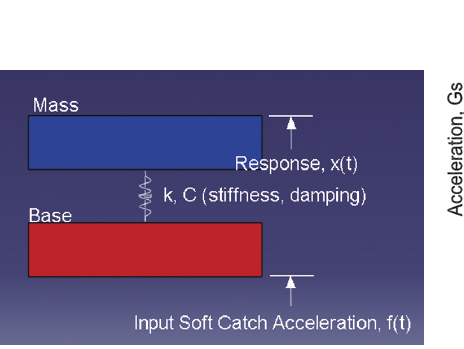
Fig. 5. Simple spring-mass system for shock response. Fig. 6. Shock response spectrum for shot #145, Q = 10. (Note: the blue curve is the axial data and the purple and green curves are transverse